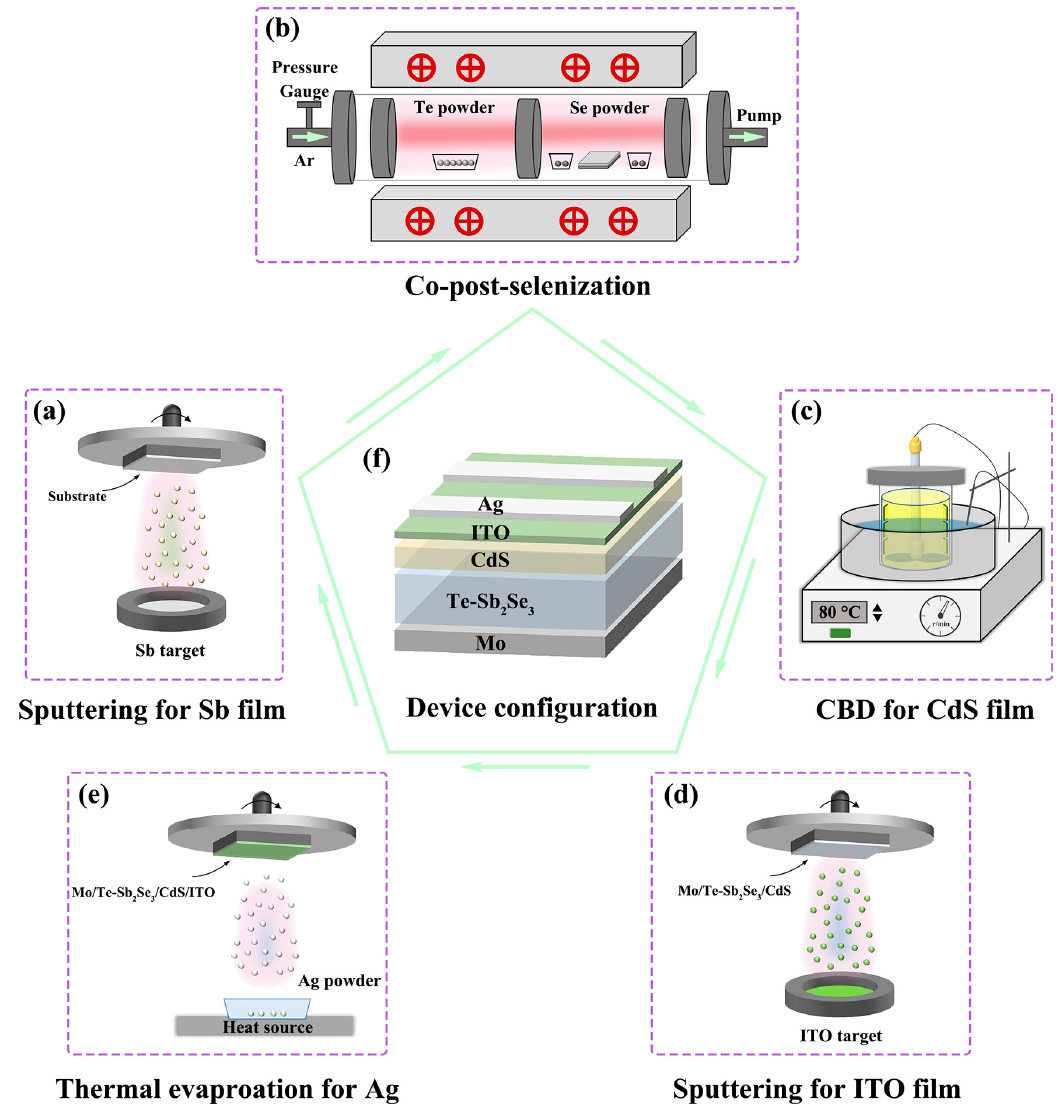
Figure 1. Schematic diagram of the preparation process of the Sb 2 Se 3 solar cell. ( a ) sputtering for Sb thin film. ( b ) Co-post-selenization heat treatment of Te-doped Sb 2 Se 3 . ( c ) Chemical bath deposition (CBD) method deposited CdS buffer layer. ( d ) A magnetron sputter-deposited ITO window layer. ( e ) Thermal evaporation for Ag electrode. ( f ) The schematic layout of the completed Te-doped Sb 2 Se 3